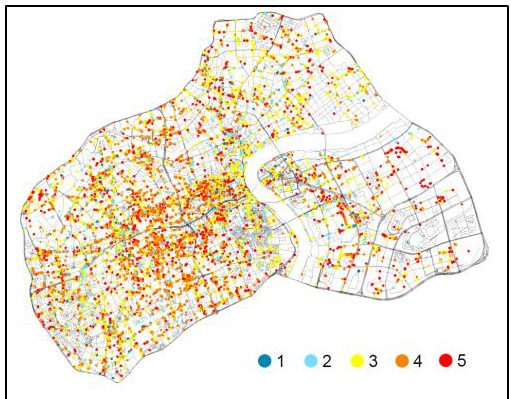
Figure 6. Rating results of willingness to stay.